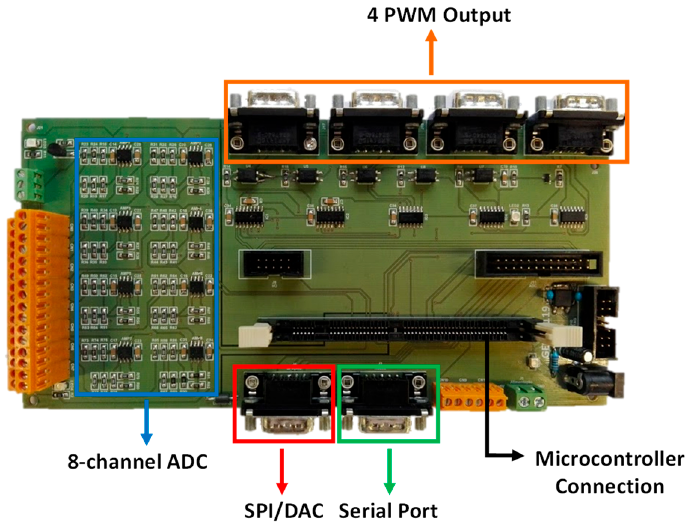
Figure 10. Developed control board of the multilevel dc–dc power converter.